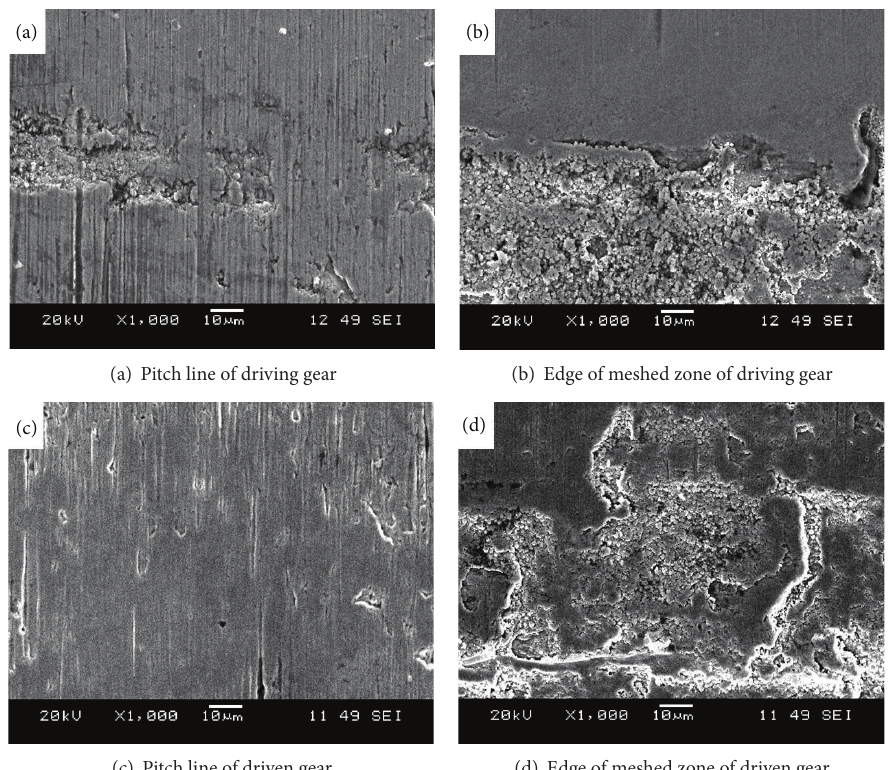
Figure 5: The SEM micrograph of nitrided gears after running